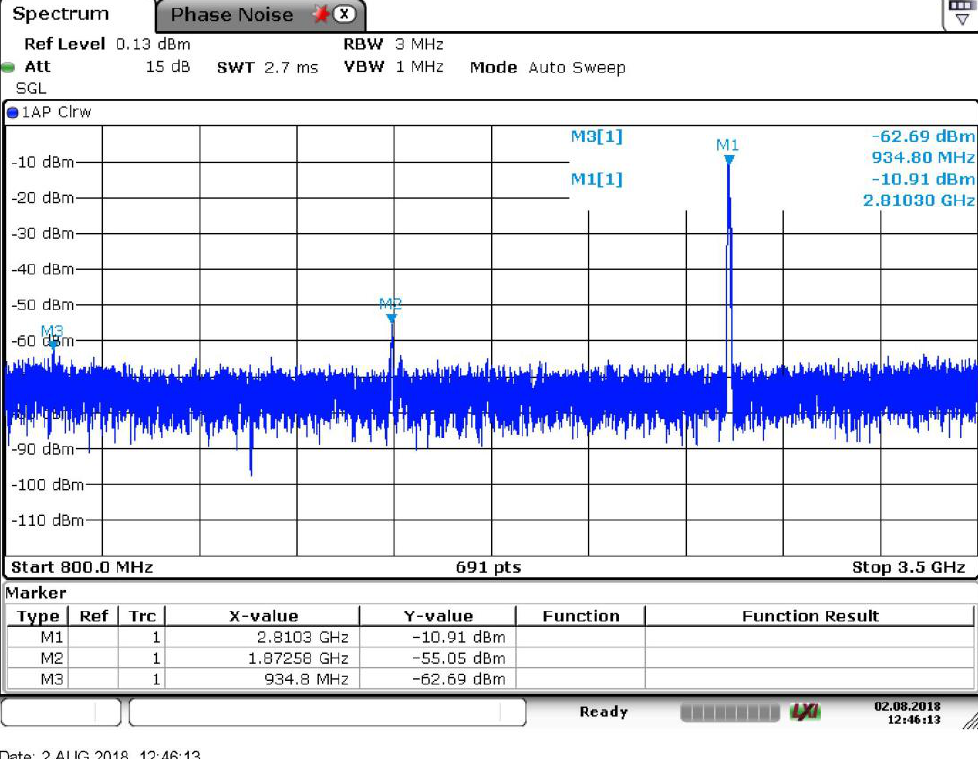
Figure 14. Measured output spectrum at 2810 MHz.